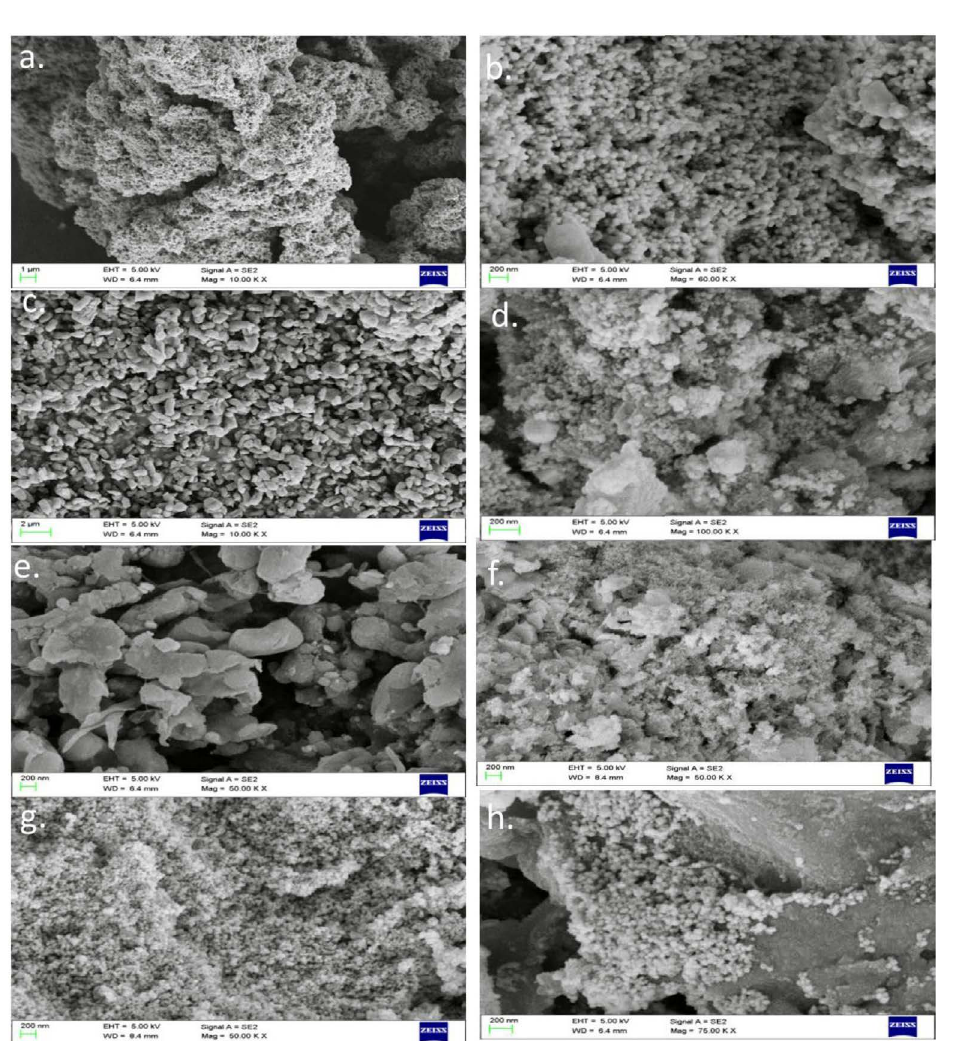
Fig. 8. SEM analysis of silver nanoparticle produced using different extracts a) Saraca indica (ethanol),b) Saraca indica (water), c) Annona recticulata (ethanol), d) Annona recticulata (water), e ) Datura metel (ethanol), f ) Datura metel (water), g) Aegle marmelos (ethanol), h) Aegle marmelos